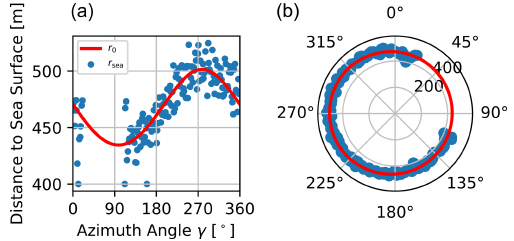
Figure 10. Example fitting of the modelled sea surface dis- tances to the measured distances for a complete SSL scan. φ ssl = − 0 . 025 ◦ ,ρ = − 0 . 201 ◦ and h = 24 . 560m. Illustrated in a reg- ssl ssl ular plot (a) and in a polar plot (b)